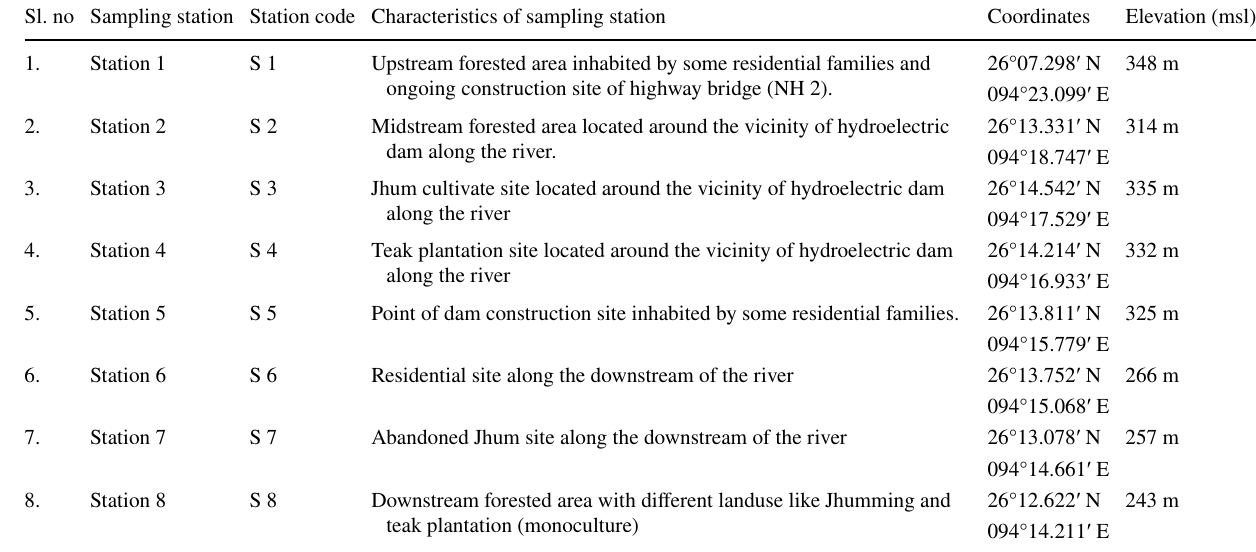
Table 1 Characteristic features of the sampling station, their coordinates and elevation along Doyang